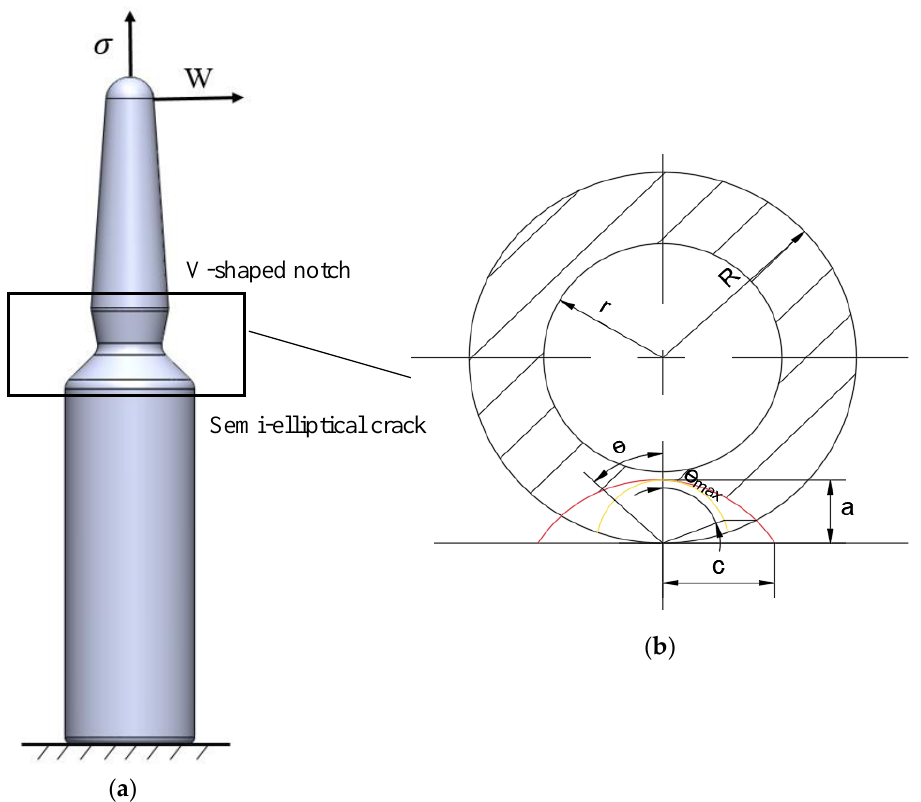
Figure 1. Pictures of the ampoule bottle and its broken parts on the neck. ( a ) Ampoule bottle. ( b ) Broken ampoule bottle.